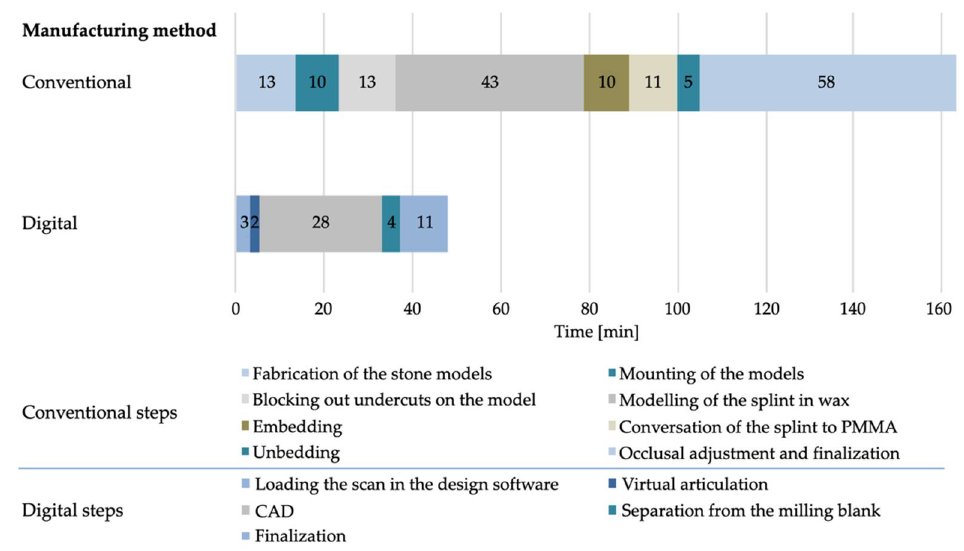
Figure 8. Time requirement for the dental technician for the different steps in minutes (min). Table 2. Results for the conventional and digital workflow showing the duration for the dentist and the dental technician, the overall fit, the static occlusion, and the wear.